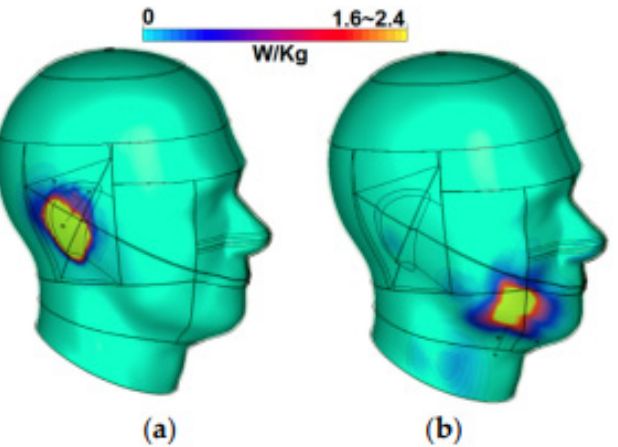
Figure 1. Analysis specific absorption rates of the smartphone antenna: ( a ) top location and ( b ) bottom location [10].